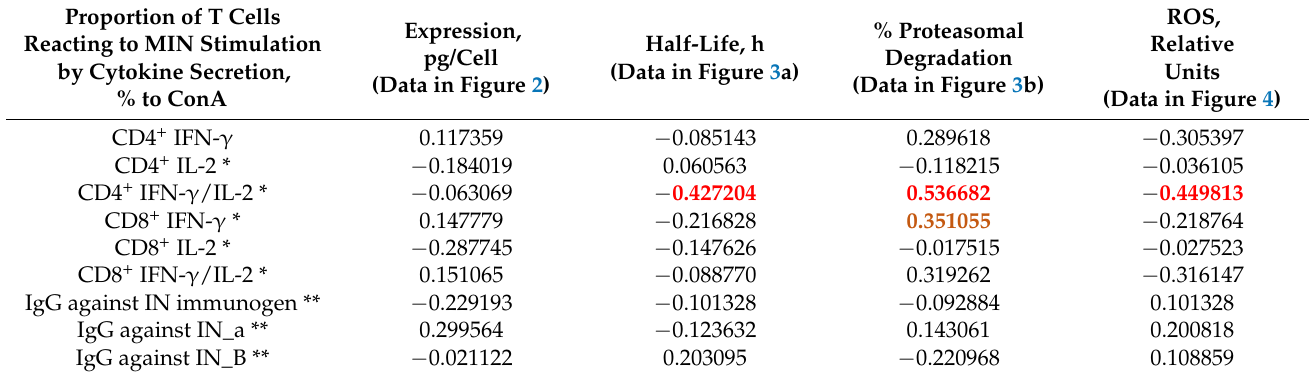
Table 2. In vitro correlates of potency of T cell response in mice DNA immunized with variants of consensus HIV-1 integrase. Table depicts correlation coefficients in the Spearman rank order correlation test between average values of each in vitro and in vivo parameter characteristic to IN variants. Statistically significant correlation coefficients ( p < 0.05) are given in red, tendency to correlate, in brown ( p <